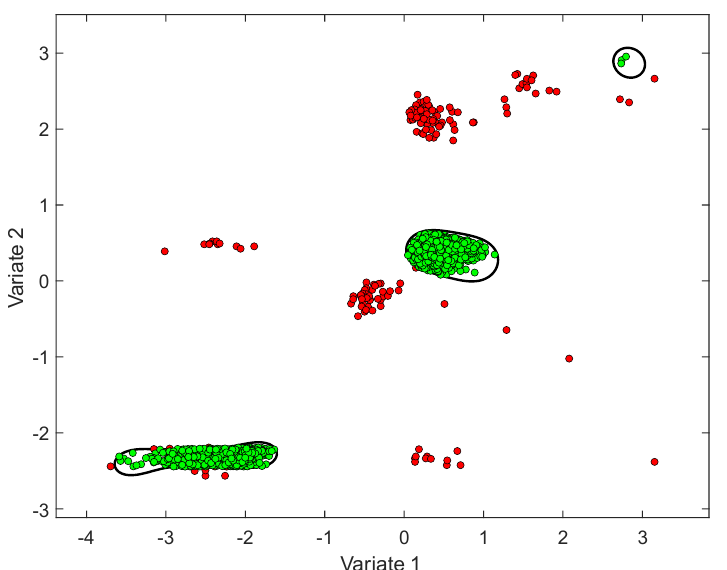
Figure 1. Illustration of two variates classified by SVDD boundaries (in black curves). Green points are inliers and red points are outliers.